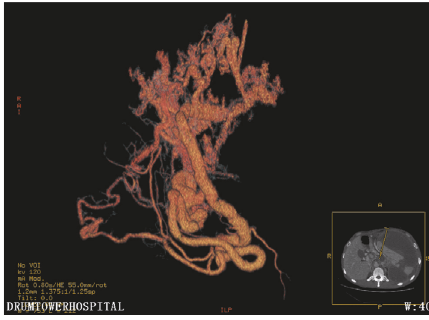
Figure 1: CT scan showing a large subcapsular splenic hematoma (16.0 × 16.0 × 7.6cm) with a large pancreatic pseudocyst (13.5 × 10.0 × 8.0 cm).